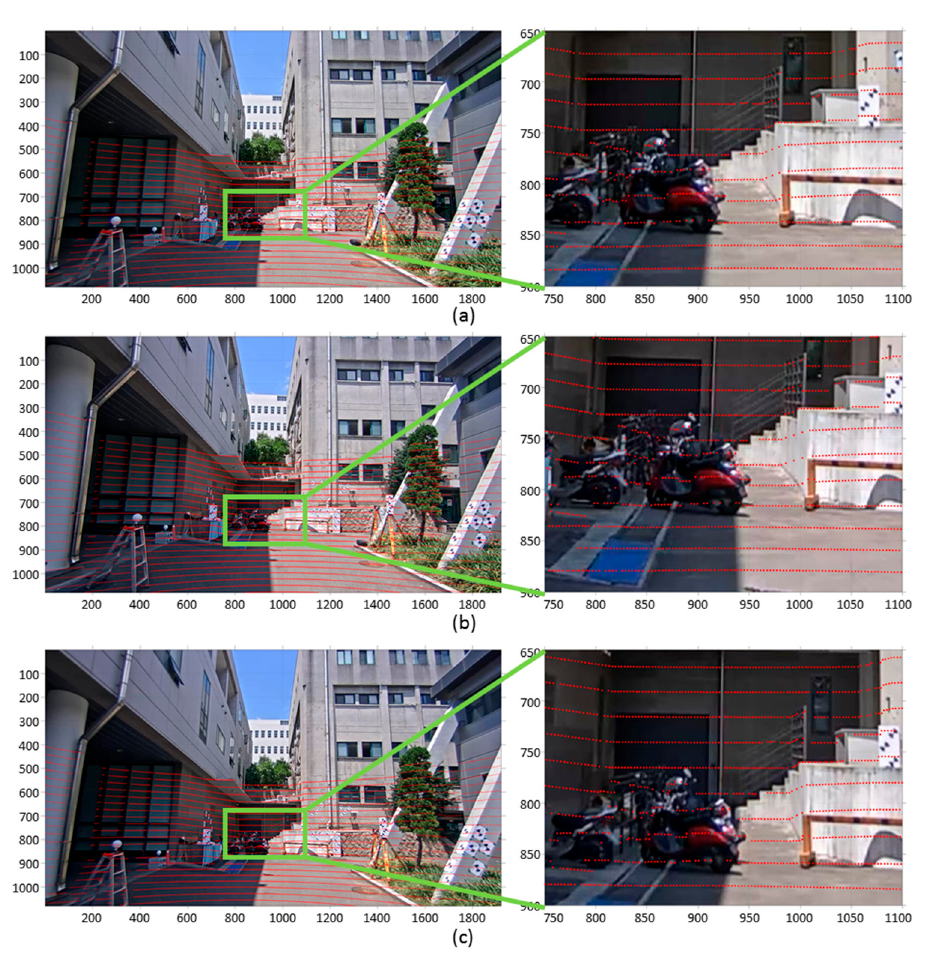
Figure 15. Projection of mobile laser scanning data into network video camera images: ( a ) CAM(F); ( b ) CAM(R); ( c ) CAM(L).